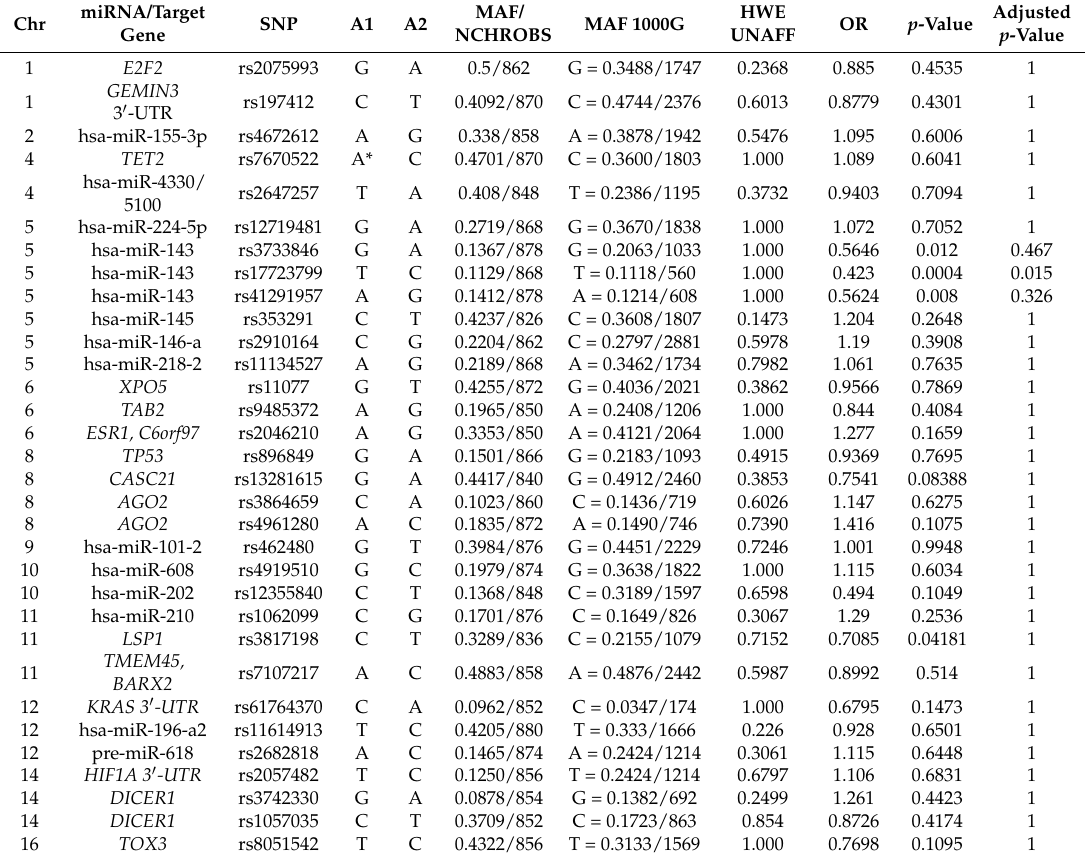
Table 3. Basic association testing for 39 genotyped SNPs showing minor allele frequencies (MAFs), Hardy-Weinberg Equilibrium (HWE) score for controls, unadjusted odds ratios, and p -values and adjusted p -values after correction for multiple testing. A1, minor allele; A2, major allele; MAF, minor allele frequency; NCHROBS, number of chromosomes observed; 1000G, 1000 Genomes Database; HWE, Hardy-Weinberg Equilibrium; OR, odds